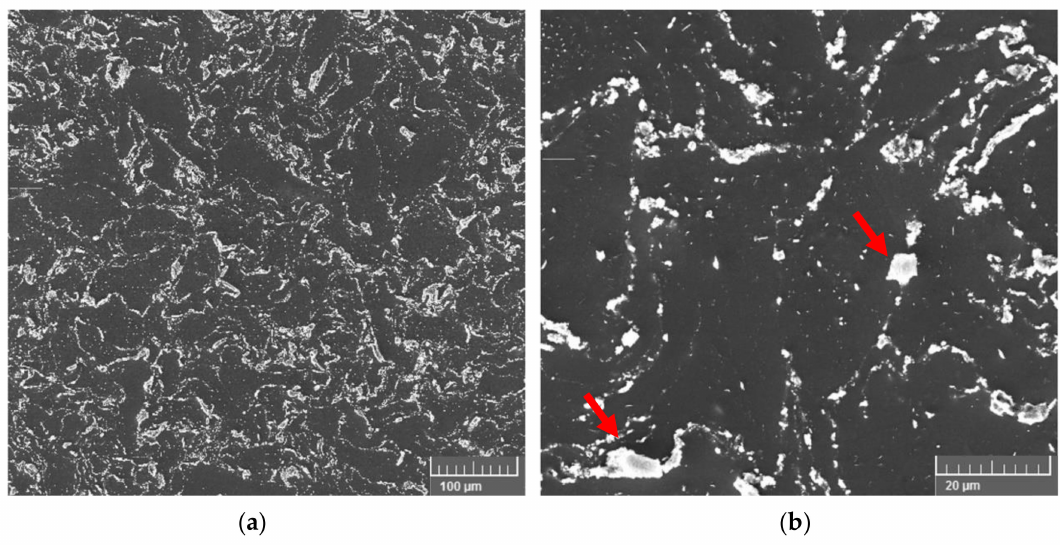
Figure 2. ( a ) SEM micrographs of the microstructure of 1 Vo1% Mg-Sm 2 O 3 nanocomposite; ( b ) An en- largement fragment of the area in ( a ), arrows indicating localized agglomeration of the